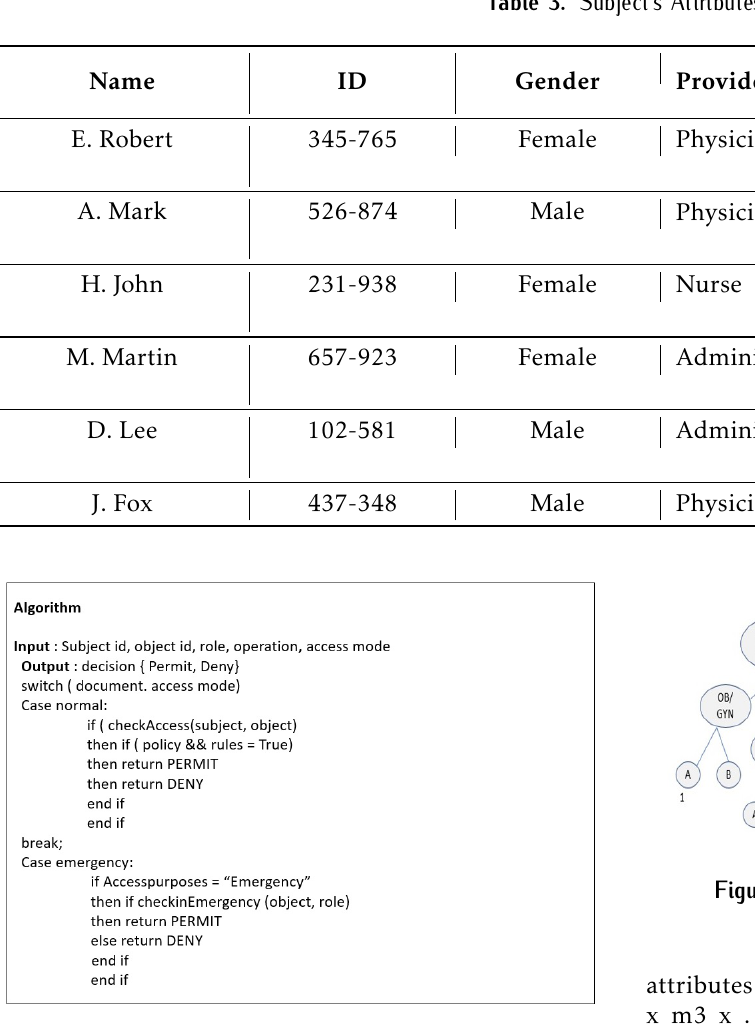
Figure 5. Algorithm for Access Control